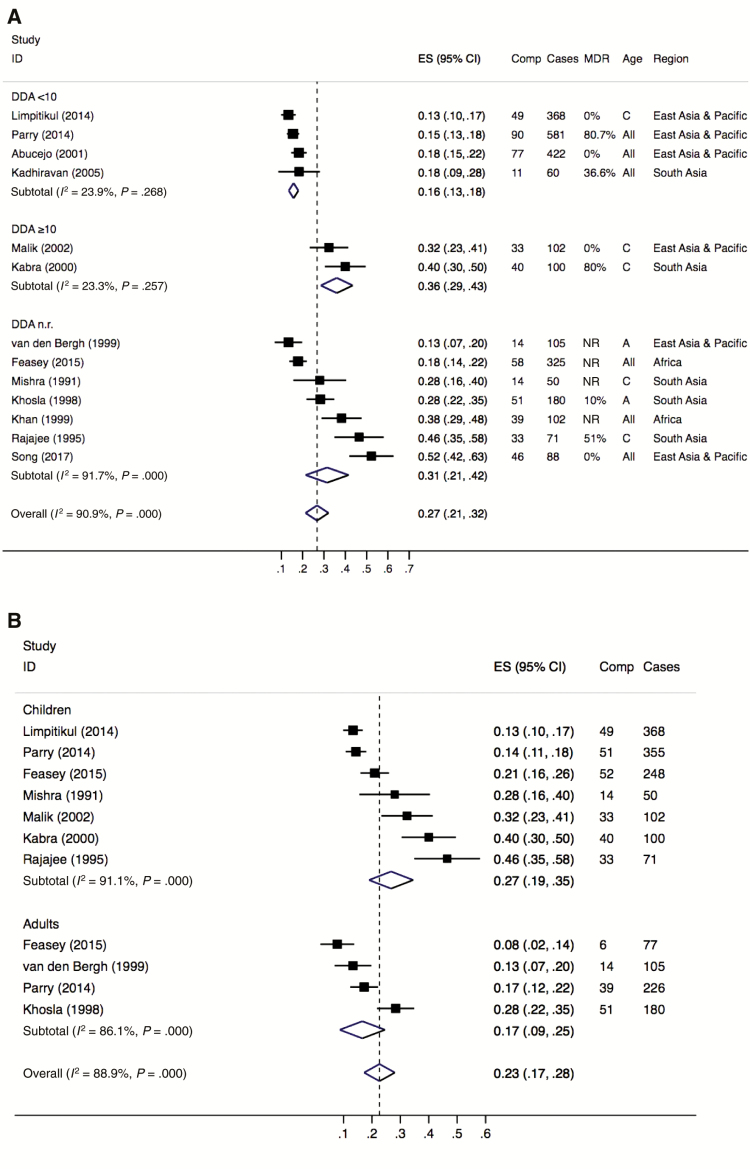
Forest plots showing the overall and subgroup prevalence of typhoid fever complications among hospitalized patients (1990–2018), by illness duration at hospitalization (A) and age (B). Abbreviations: A adults; All, all ages; C, children; CI, confidence interval; Comp, complications; DDA, mean/median illness duration (days) at hospitalization; ES, estimated prevalence; ID, study ID, study identification-first author (year of publication); MDR, multidrug antimicrobial resistance reported in each study; NR, not reported.